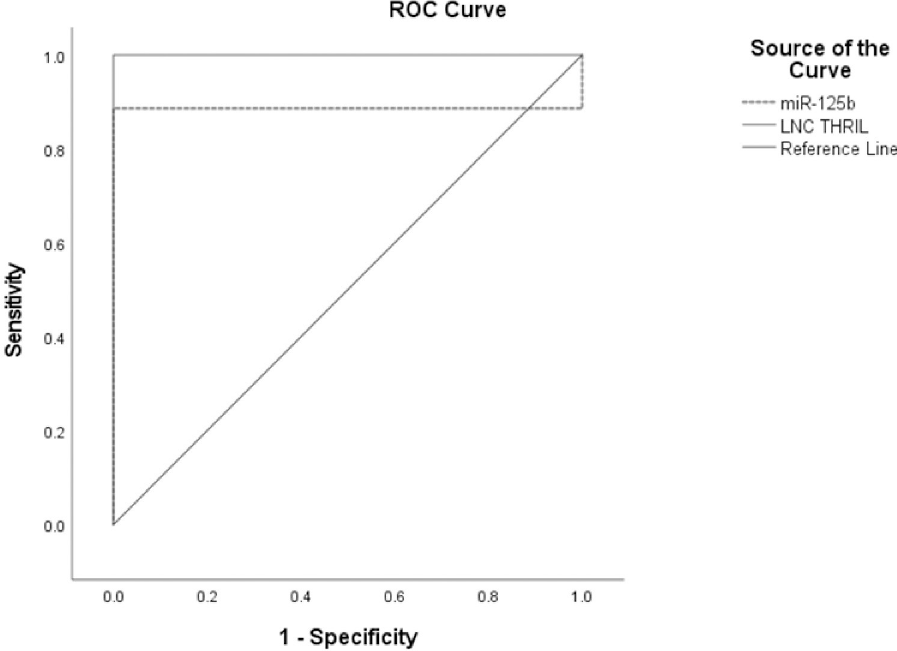
Fig 2. Receiver operating characteristic of sensitivity and specificity of Lnc THRIL and MiR-125b in CD patients vs. controls.